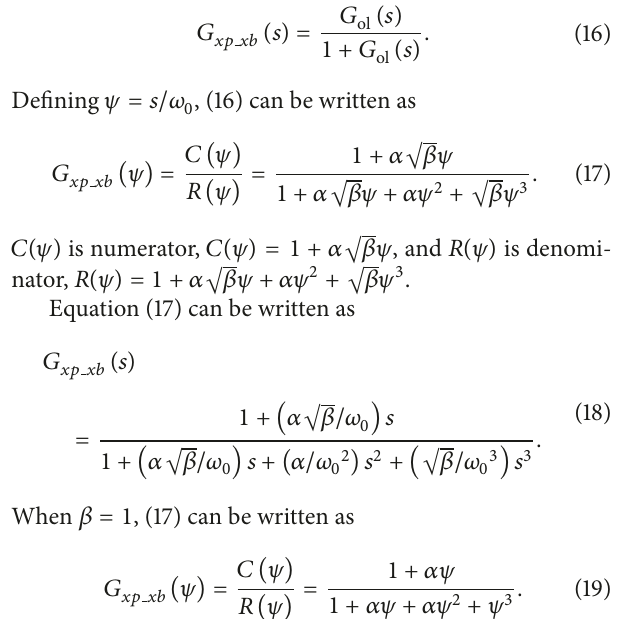
Figure 5: Root locus ( 𝛼 < 3